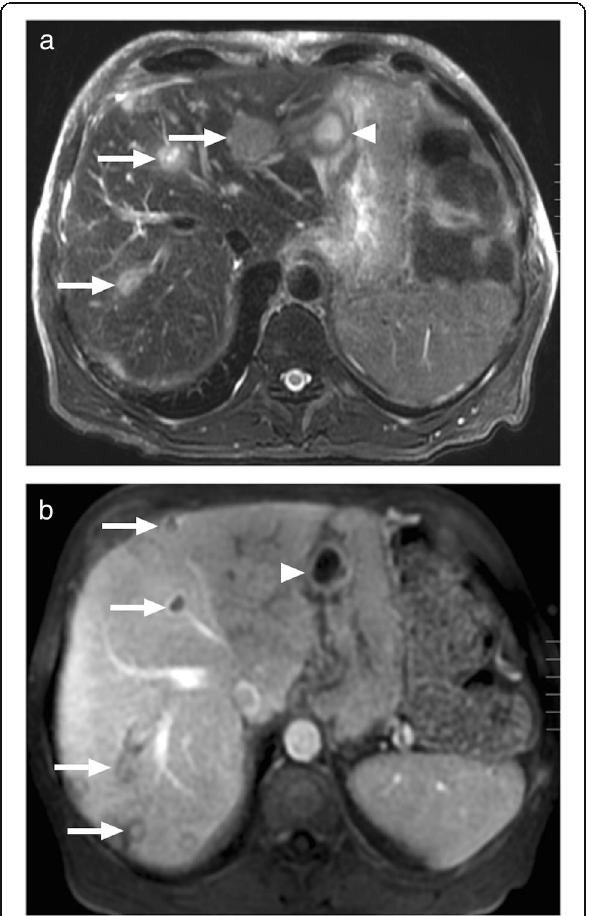
Fig. 16 A 66-year-old male with poorly controlled diabetes presented with abdominal pain, fever and weight loss. a Axial plane T2W MR image demonstrates hyperintense, predominantly cystic lesions (arrows). Also note is made of necrotic lymph node in the gastrohepatic ligament (arrowhead). b Axial plane postcontrast T1W MR image demonstrates intense peripheral contrast enhancement (arrows). Percutaneous biopsy confirmed actinomyces